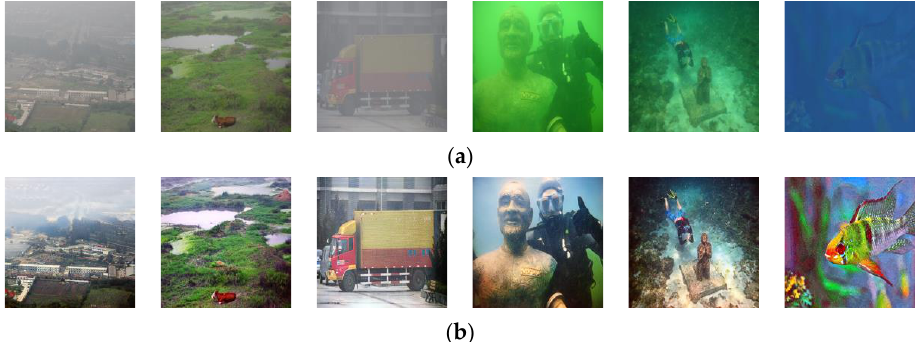
Figure 9. Visualization results of the proposed method on haze images and underwater images; ( a ) Haze images and underwater images; ( b ) Enhancement results of the proposed